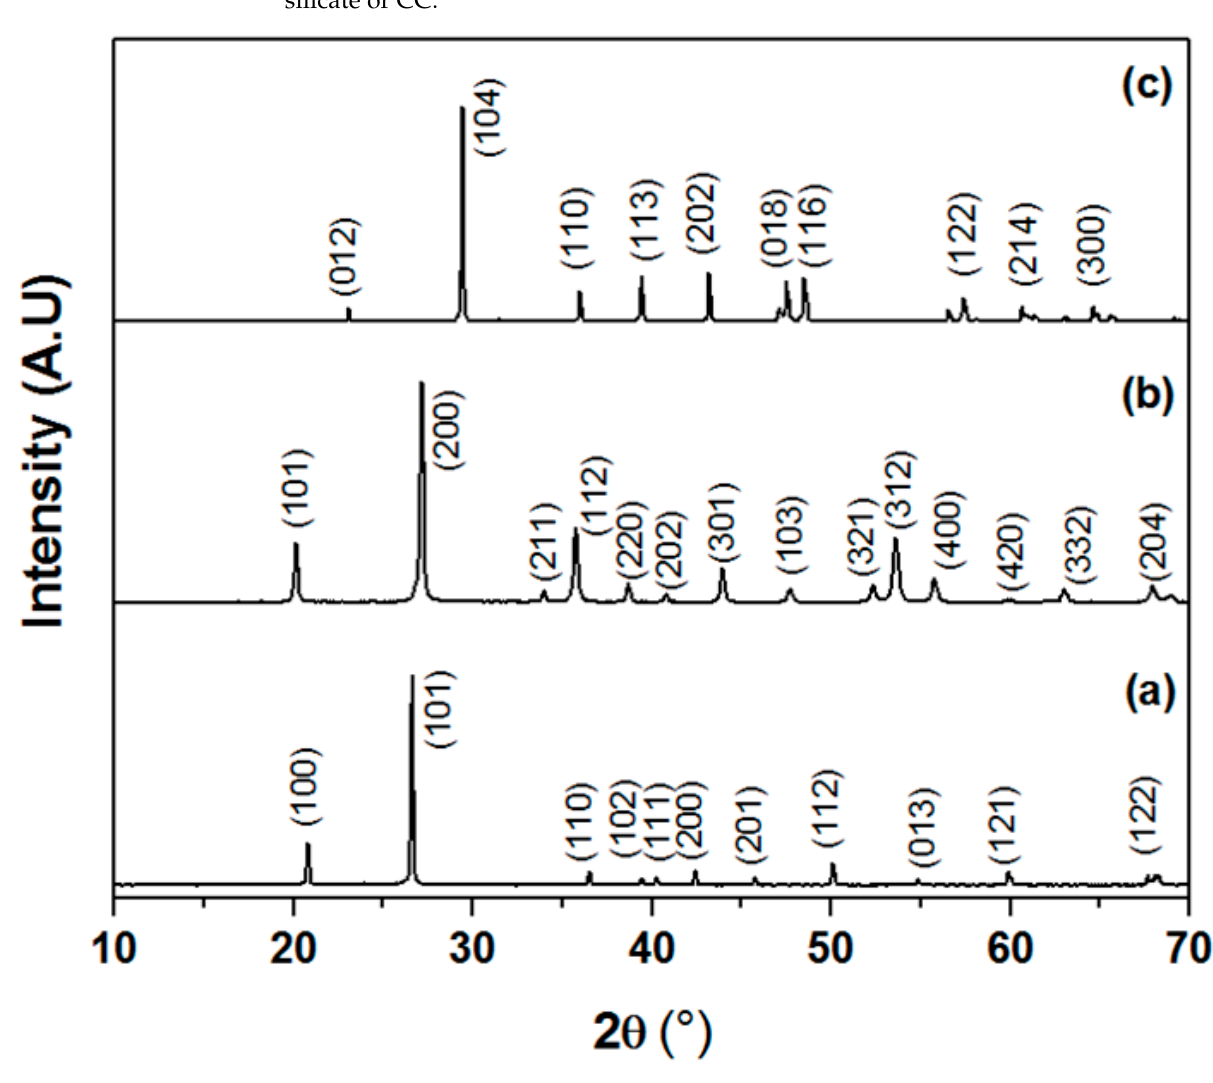
Figure 2. XRD spectra of raw materials, ( a ) SS, ( b ) zirconium silicate powders, and ( c ) CC powders, respectively. Table 1. Chemical compositions of raw materials, expressed as weight percentage, for the different oxides (obtained with the X-ray fluorescence